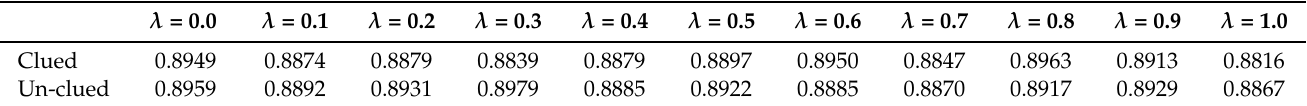
Table 2. Validation accuracy by λ (length = 280 tokens).